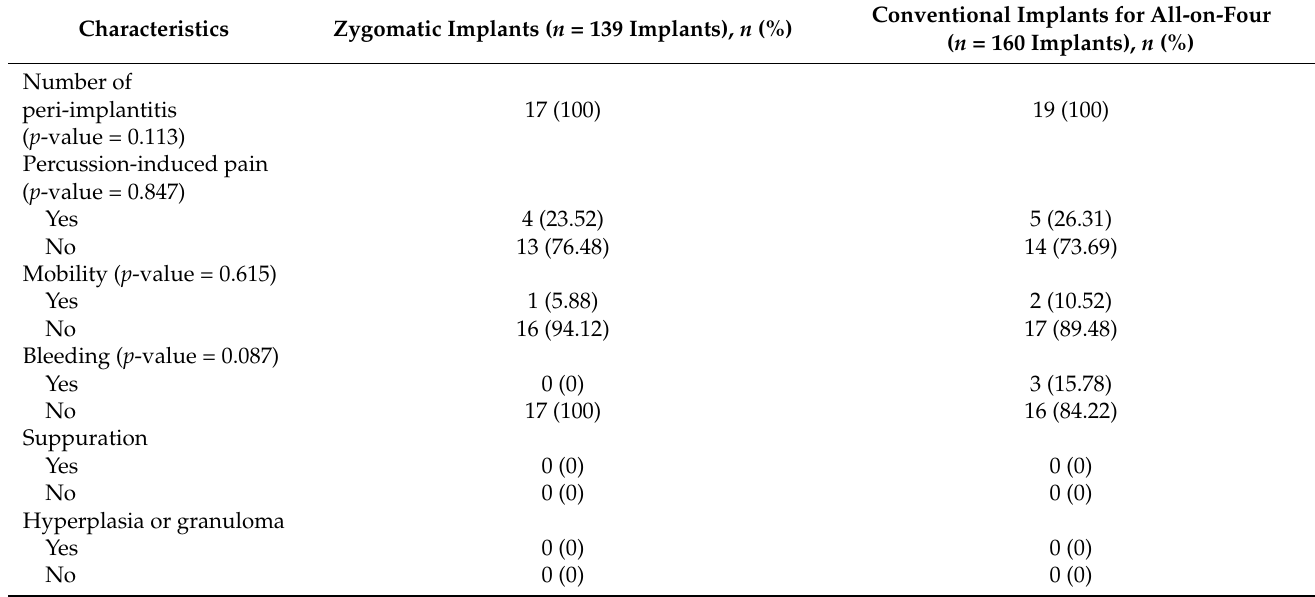
Table 3. Characteristics of dental implants presenting peri-implantitis (Pearson’s χ 2 test). Characteristics